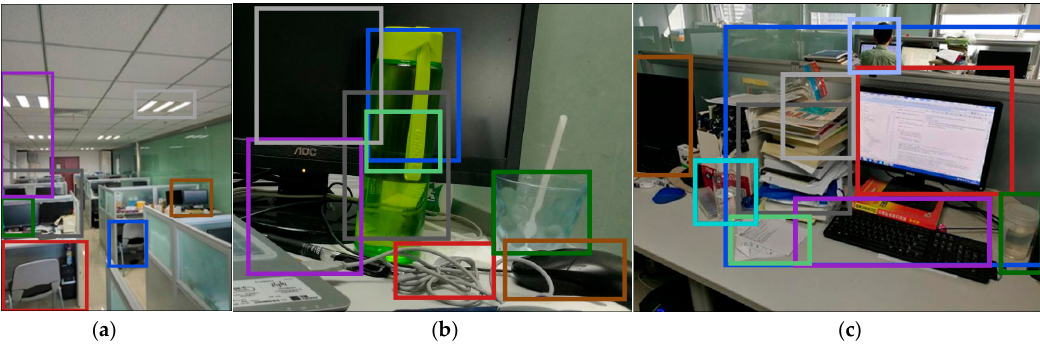
Figure 12. The object detection results using HOGP for scaled scenes. ( a ) Indoor scene; ( b ) desktop object detection; ( c ) indoor object detection.